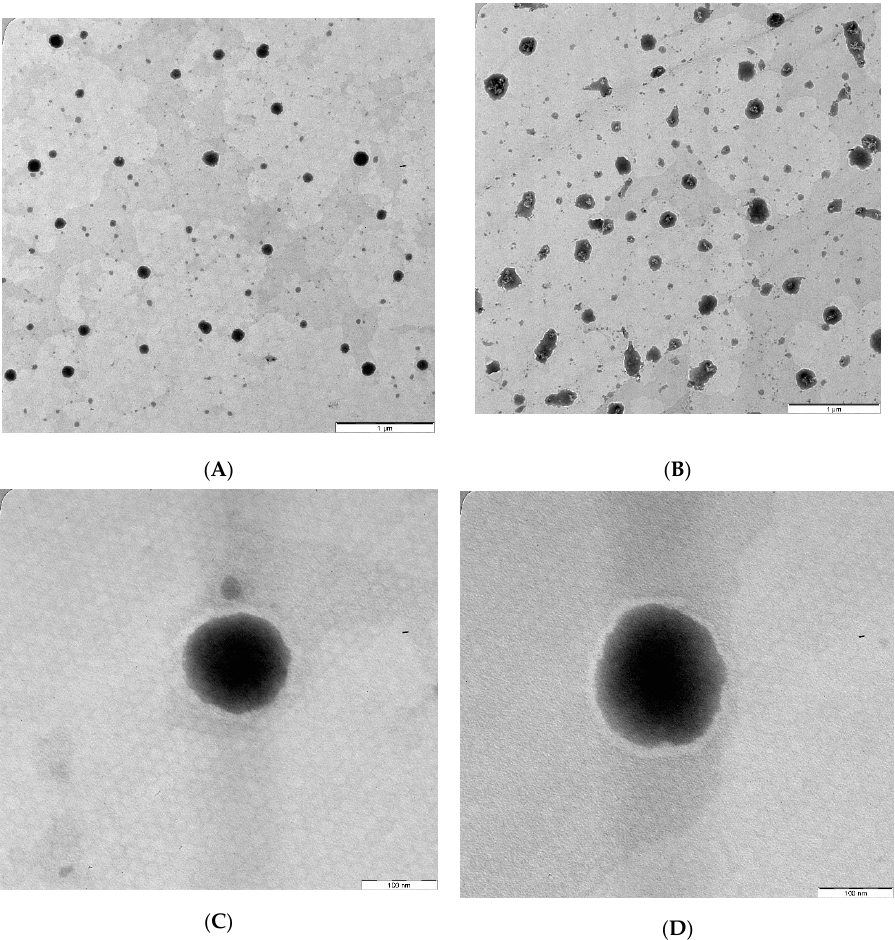
Figure 4. TEM images of the optimized AZM-loaded liquid and solid SEDDs formulations. ( A ) AZM- L-F1 (H) Dispersion; ( B ) AZM-S-F1 (H) Dispersion; ( C ) Individual droplet of AZM-L-F1 (H); ( D ) Individual droplet of AZM-S-F1 (H).